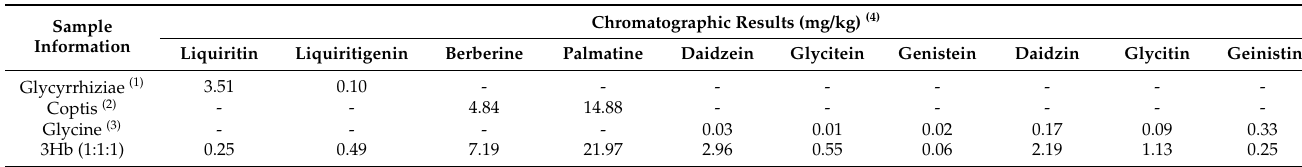
Figure 1. The high-performance liquid chromatography profile of Three Herb (3Hb) and 3Hb ex tract 3Hb means Rhizome of Coptis chinensis , Rhizome of Glycyrrhiza uralensis , and fermented Semen of Glycine max . Markers were eluted in the stand- ard solution ( Rhizome of Glycyrrhiza uralensis ( A ), Rhizome of Coptis chinensis ( B ), fermented Semen of Glycine max ( C , D )), 3 Hb extract ( E ). Peak number: markers of liquiritin (1), liquiritigenin (2, berberine (3), palmatine (5) and isoflavones such as daidzein (5), glycitein (6), genistein (7), daidzin (8), glycitin (9), and genistin (10). Table 1. Contents (mg/kg) of the markers of processed herbal medicine extracts evaluated by high-performance liquid chromatography .